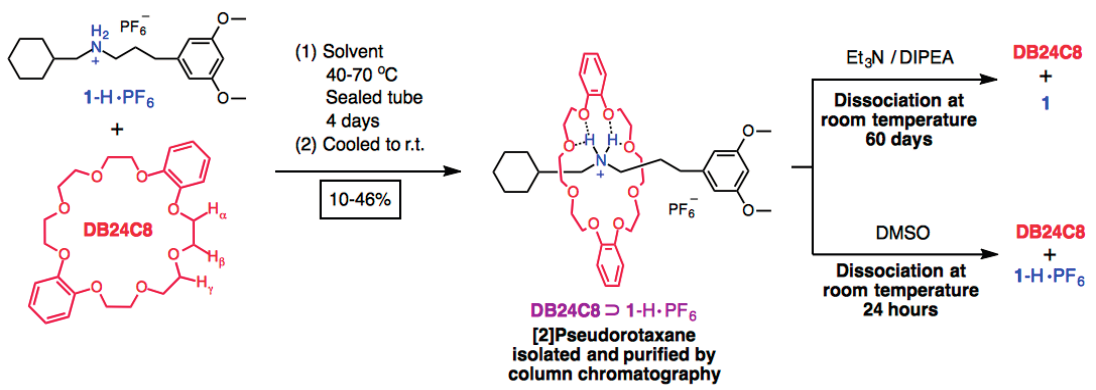
Figure 1. Molecular structures of the crown ether DB24C8 and the ammonium thread “dumbbell” 1 -H·PF 6 . The 3,5-dimethoxyaryl group of the thread acts as an effective